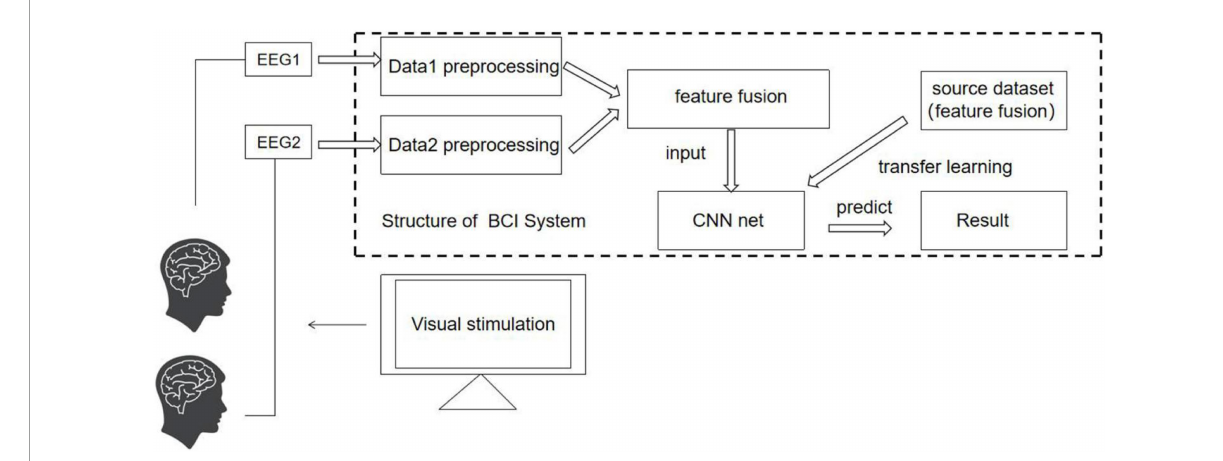
FIGURE1 Centralized cBCI structure designed in this